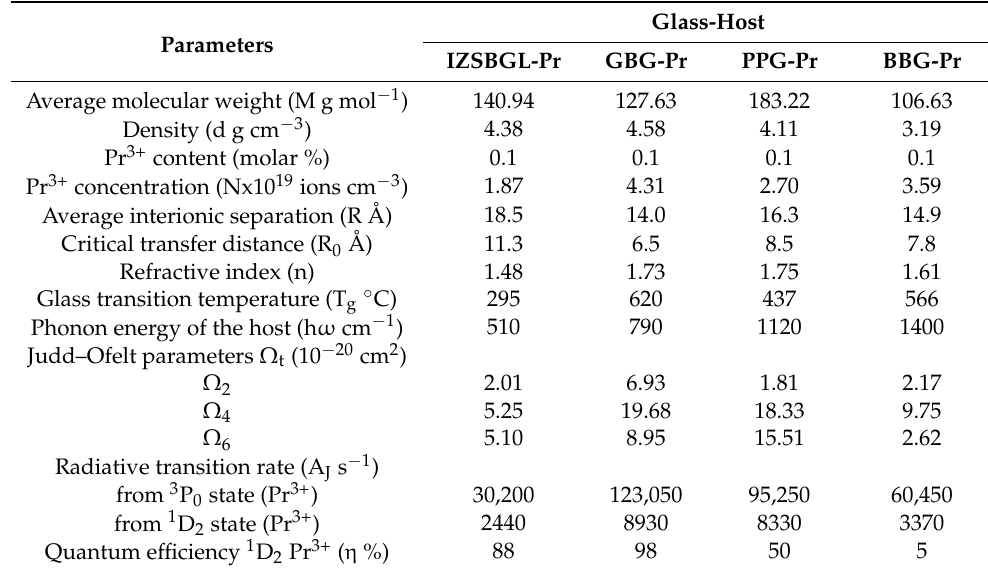
Table 3. Different physicochemical properties of the studied Pr 3+ -doped inorganic glasses [56–59]. Parameters